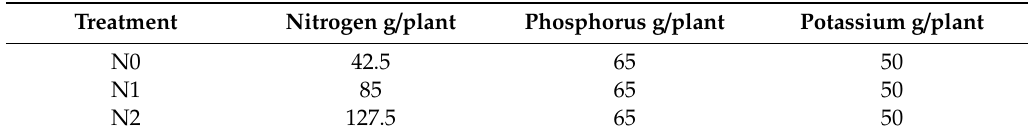
Table 1. Experimental